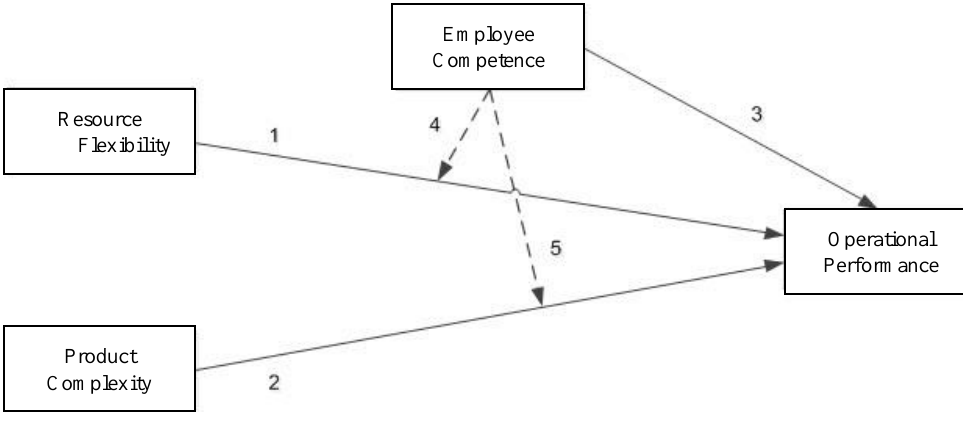
Figure 2: Research Framework and